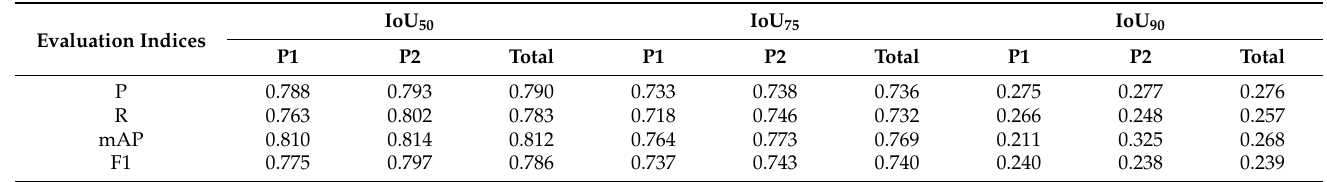
Table 9. Detection indexes of the attacked testing dataset.